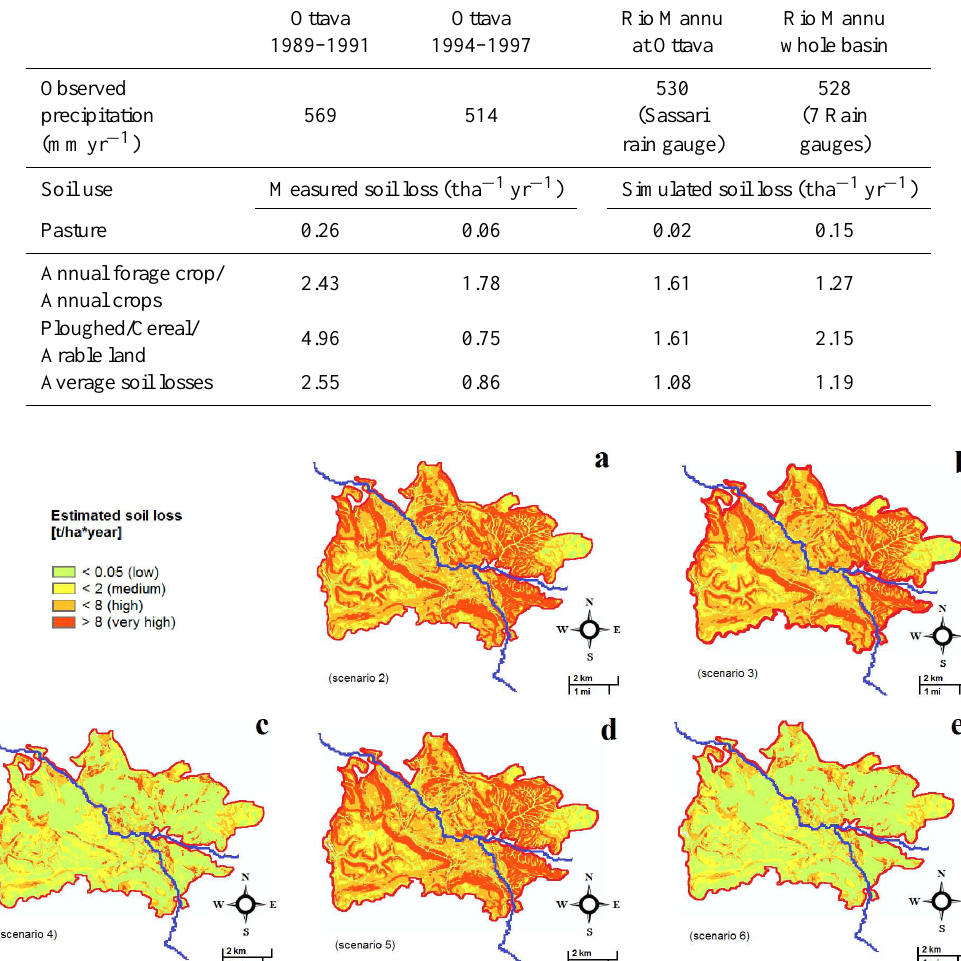
Fig. 5. Simulated soil losses under: (a) burned scenario (Scenario 2); (b) to (d) single soil erosion mitigation treatments (Scenario 3 to 5); and (e) combined mitigation treatments (Scenario